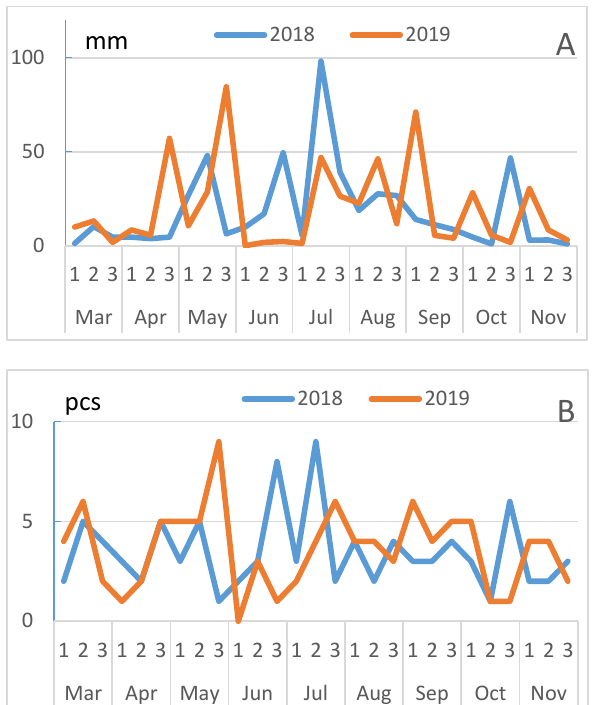
Figure 2. Rainfall distribution ( A ) and the number of days with rainfall ( B ) in 10-day intervals during the vegetation seasons.